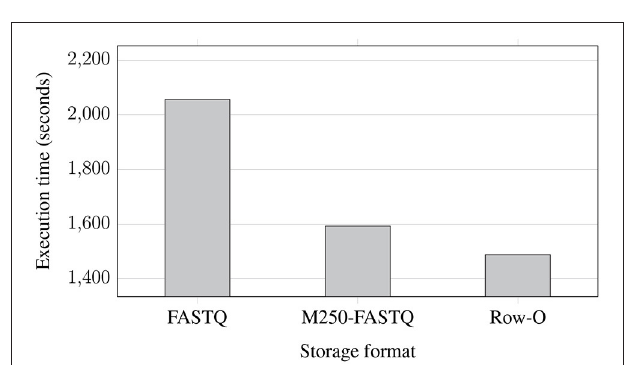
FIGURE 5 | Processing times of NGS data extracted from compressed files and saved to eight compressed FASTQ files (two files for each of the processed genomes) with 8 AUs for various storage formats: regular FASTQ, multiple 250 MB FASTQ (M250-FASTQ), and row-oriented (Row-O).